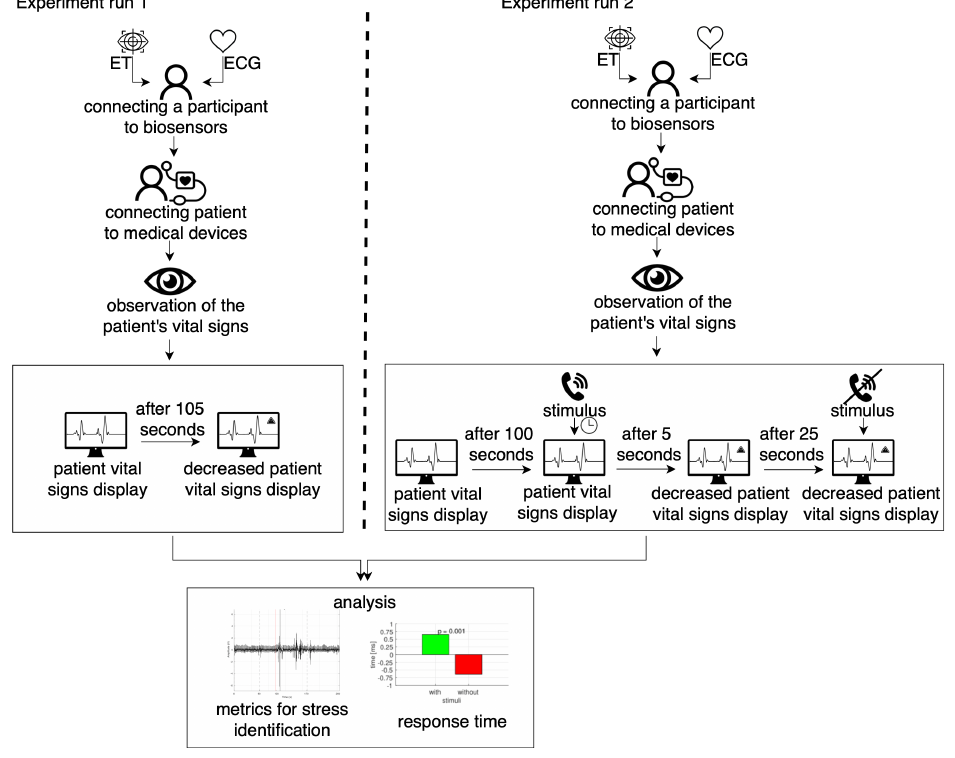
Figure 3. Experiment